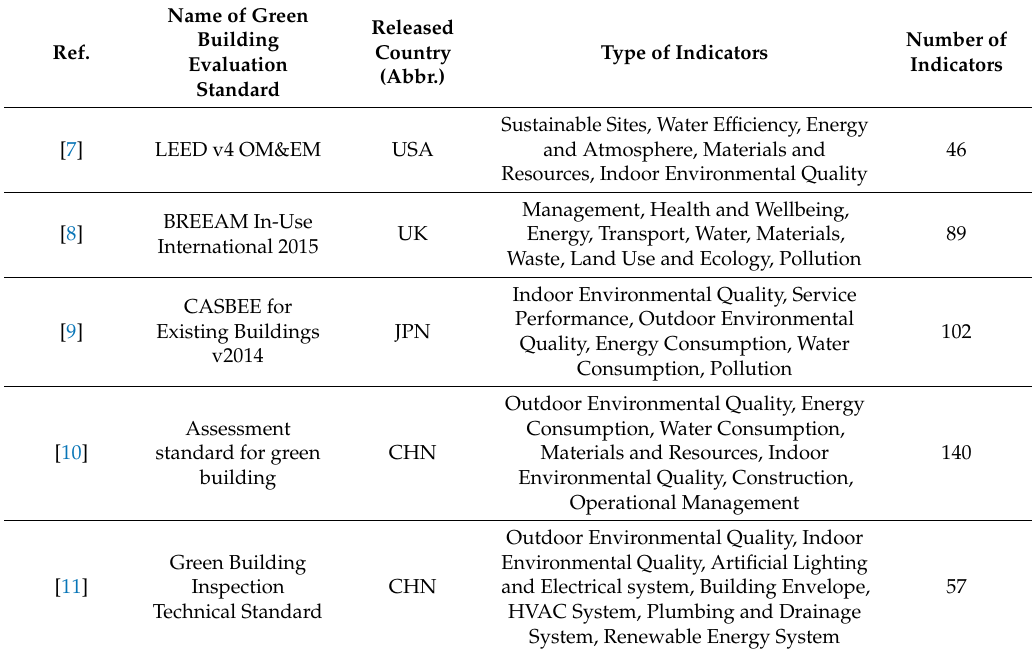
Table 1. The summary of type and number of indicators proposed by typical green building evaluation standards for operation stage.